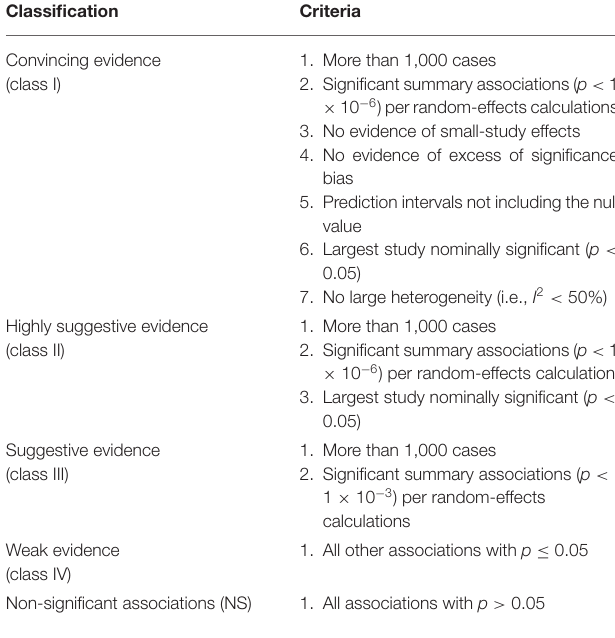
TABLE 1 | Main criteria for evaluation of the credibility of the evidence of observational